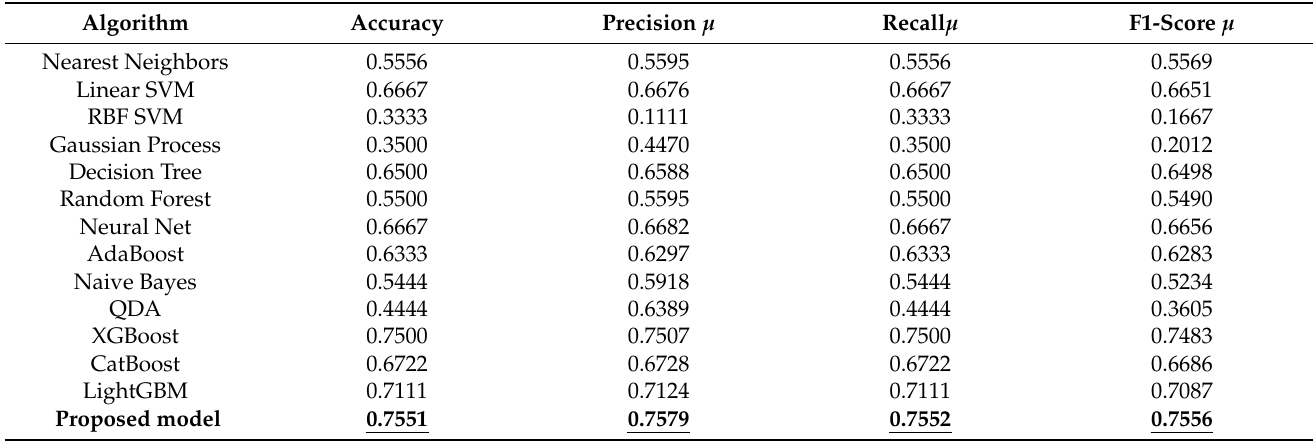
Table 5. Age classification of Akitakomachi rice